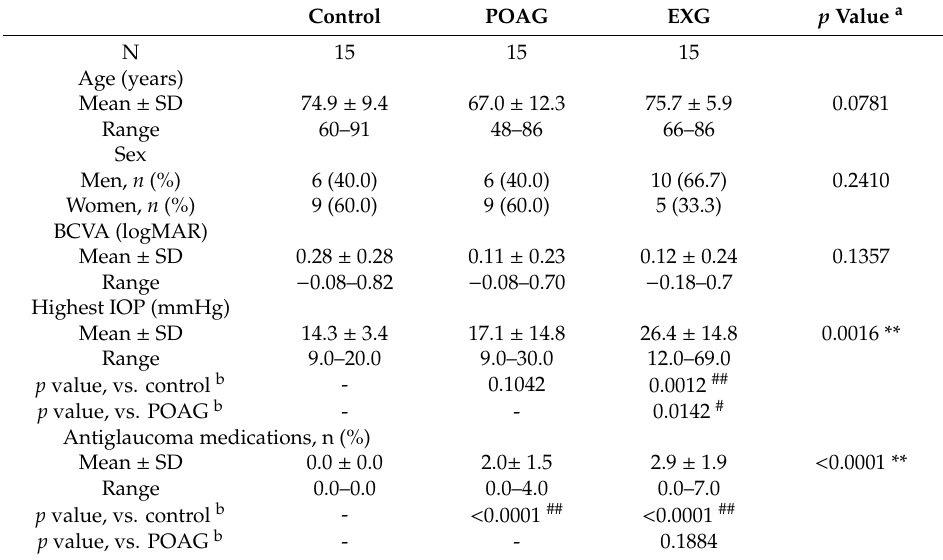
Table 1. Demographic subject